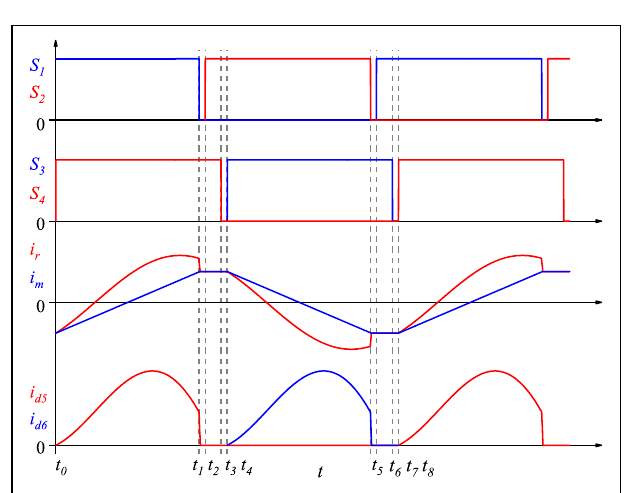
FIGURE 3 | Theoretical operating waveforms of LLC resonant converter under PFM and PSM hubrid